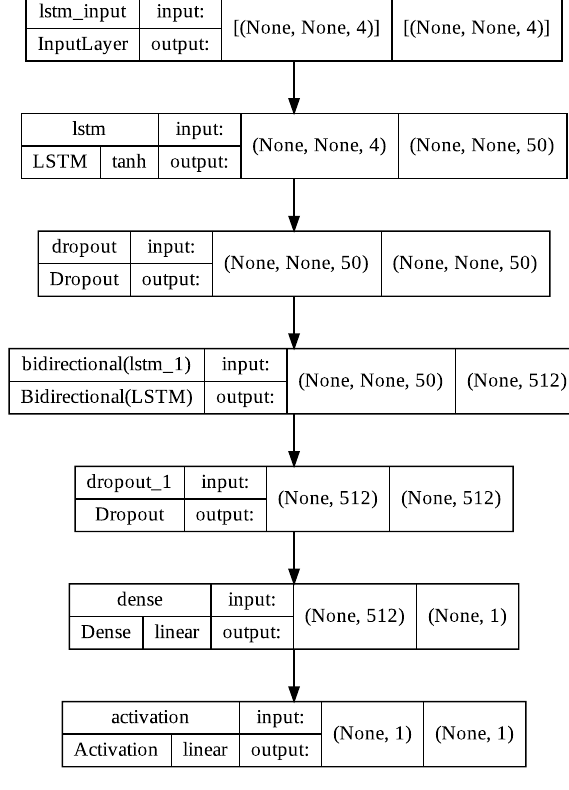
Fig. 6 A graphical presen- tation of the hierarchy of the BiLSTM model using a sequence length of 50. The graph is generated from TensorFlow